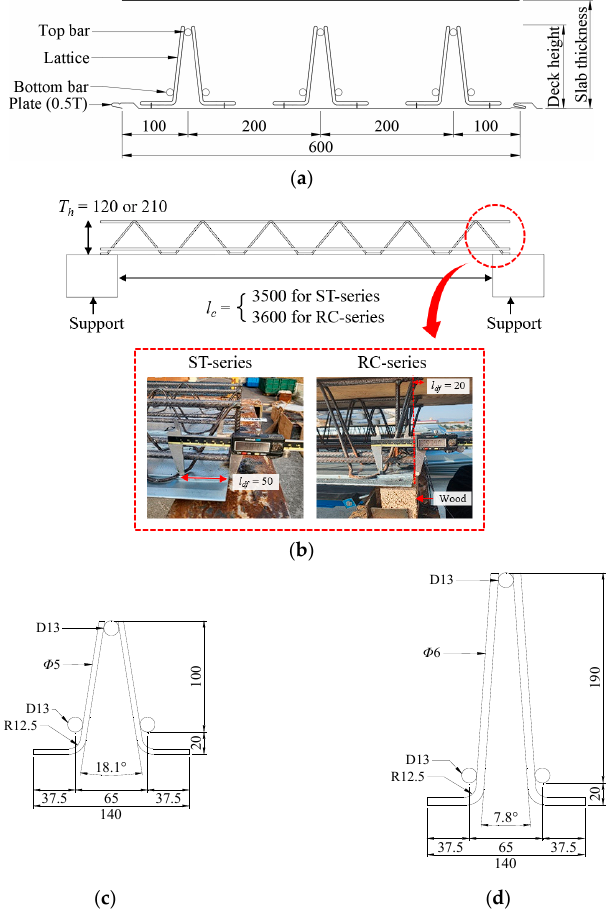
Figure 2. Details of each lattice truss girder (units in mm). ( a ) Section of wire-integrated steel deck plate. ( b ) Size details of wire-integrated steel deck plate. ( c ) Lattice truss girder of 120 mm. ( d ) Lattice truss girder of 210 mm.